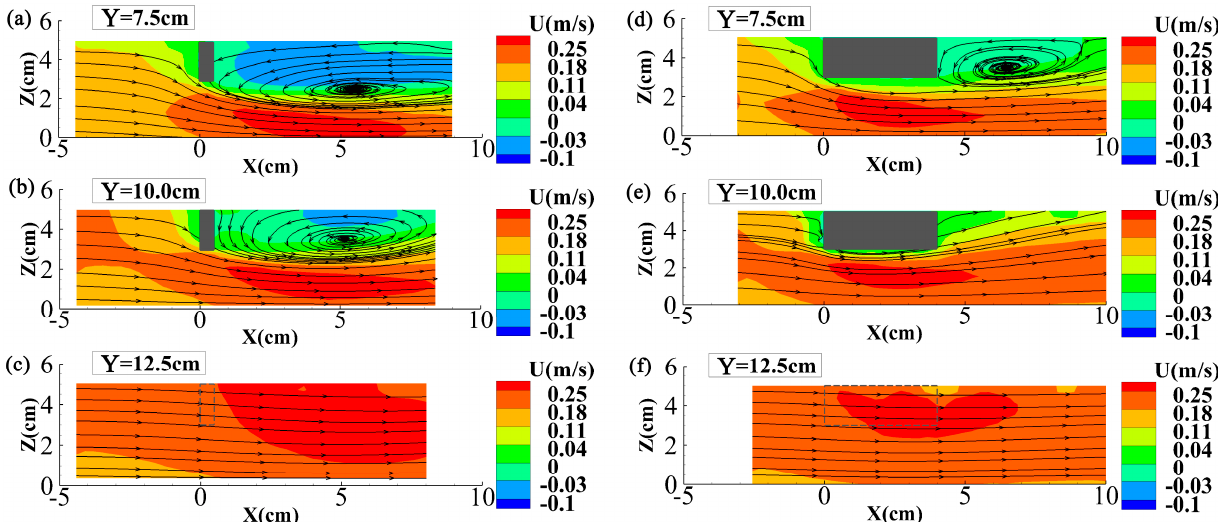
Figure 14. Distributions of velocity at longitudinal sections ( a ) Y = 7.5 cm, ( b ) Y = 10.0 cm, ( c ) Y = 12.5 cm in Case 7 (on the left) and at longitudinal sections ( d ) Y = 7.5 cm, ( e ) Y = 10.0 cm, ( f ) Y = 12.5 cm in Case 8 (on the right). The grey areas in subfigures ( a ), ( b ), ( d ) and ( e ) demonstrate the floating dike, and the dotted lines in subfigures ( c ) and ( f ) indicate the location of floating dike in the coordinate system.